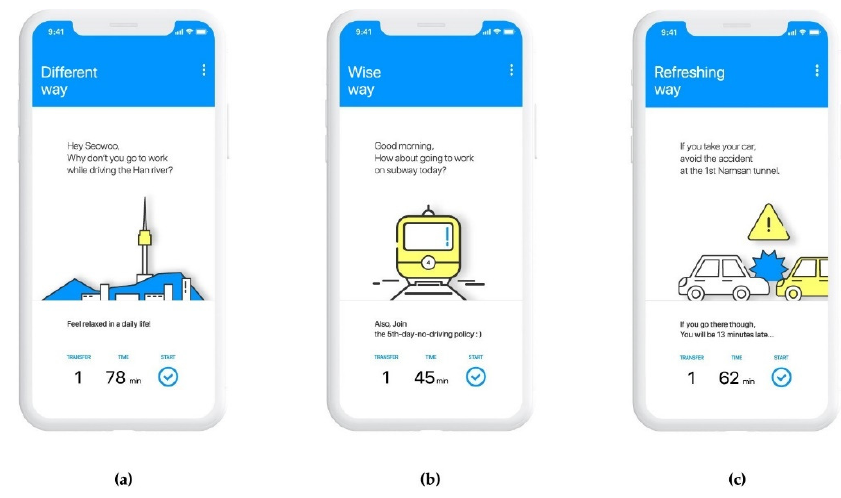
Figure 13. Display of ( a ) "Different way to work"; ( b ) "Wise way to work"; ( c ) "Refreshing way to work" in the mobile application.